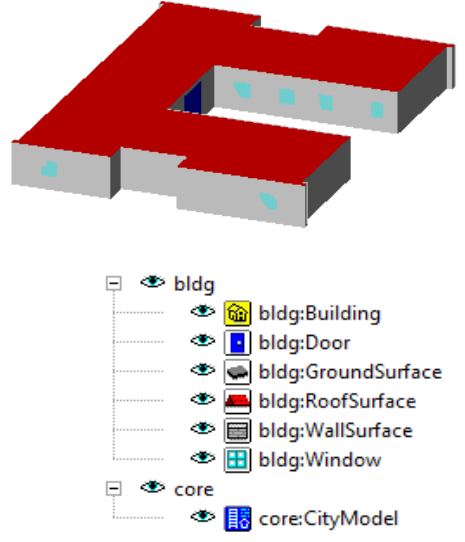
Figure 15: The geodatabase of the 3DCIM in this case study